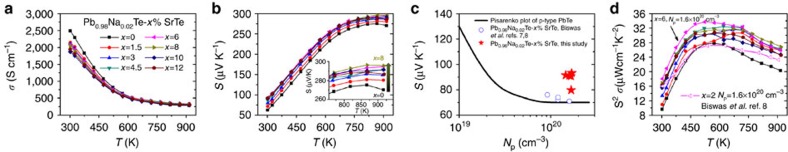
Enhanced electrical properties of Pb0.98Na0.02Te–x%SrTe by band structure modification.(a) Electrical conductivity and (b) Seebeck coefficient and (d) power factor as a function of temperature for Pb0.98Na0.02Te–x%SrTe. Inset of b is an expanded view of the Seebeck coefficient of Pb0.98Na0.02Te–x%SrTe between 700–923 K, showing a gradual enhancement of Seebeck coefficient with x increasing from 0 to 8.The open symbols in d denote Pb0.98Na0.02Te–2%SrTe under equilibrium processing8. (c) Room temperature Seebeck coefficient as a function of hole concentration (Np) for Pb0.98Na0.02Te–x%SrTe. The solid line is the theoretical Pisarenko plot for pure PbTe1434. The data of equilibrium prepared samples of Pb0.98Na0.02Te–x%SrTe by Biswas et al. are also included for comparison78. The Seebeck coefficients in the non-equilibrium samples are enhanced by ∼30%.